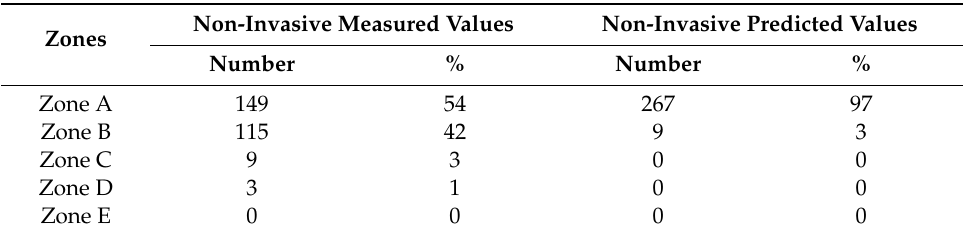
Figure 5. Clarke error grid analysis (CEGA) plot for the dataset 1. ( a ) For non-invasive measured values, ( b ) for non-invasive predicted values. Table 11. CEGA plot summary for the dataset